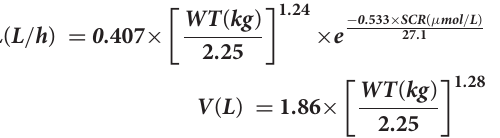
Model 2: The PPK model of vancomycin for Chinese infants with ARC.